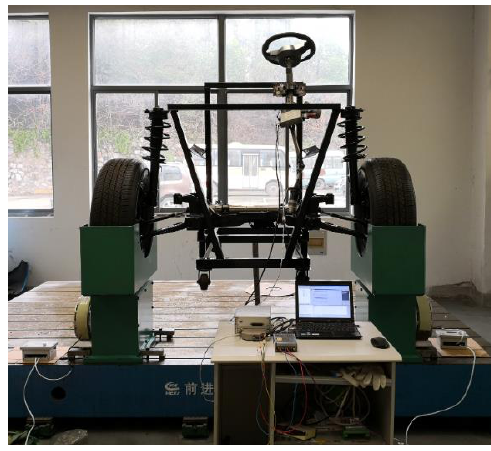
Figure 11. Test bench overall structure.